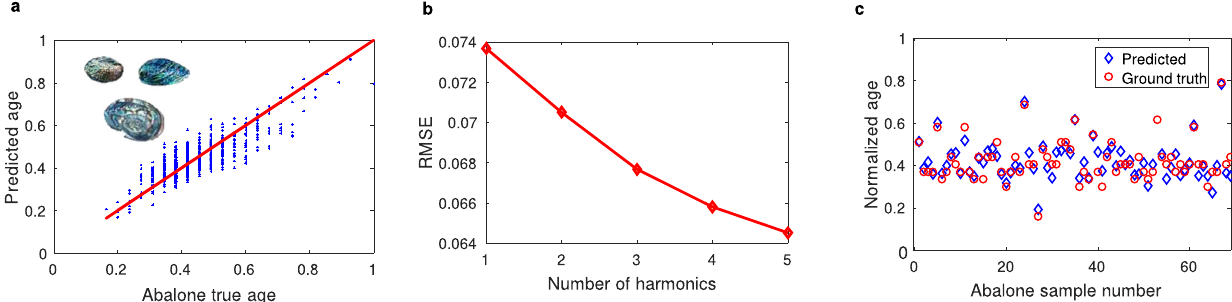
Fig. 5 Floquet extreme learning for multivariable regression. a , b Learning of the abalone dataset and corresponding RMSE for different numbers of considered harmonic waves, respectively. c Comparison between predicted data (blue) and ground truth